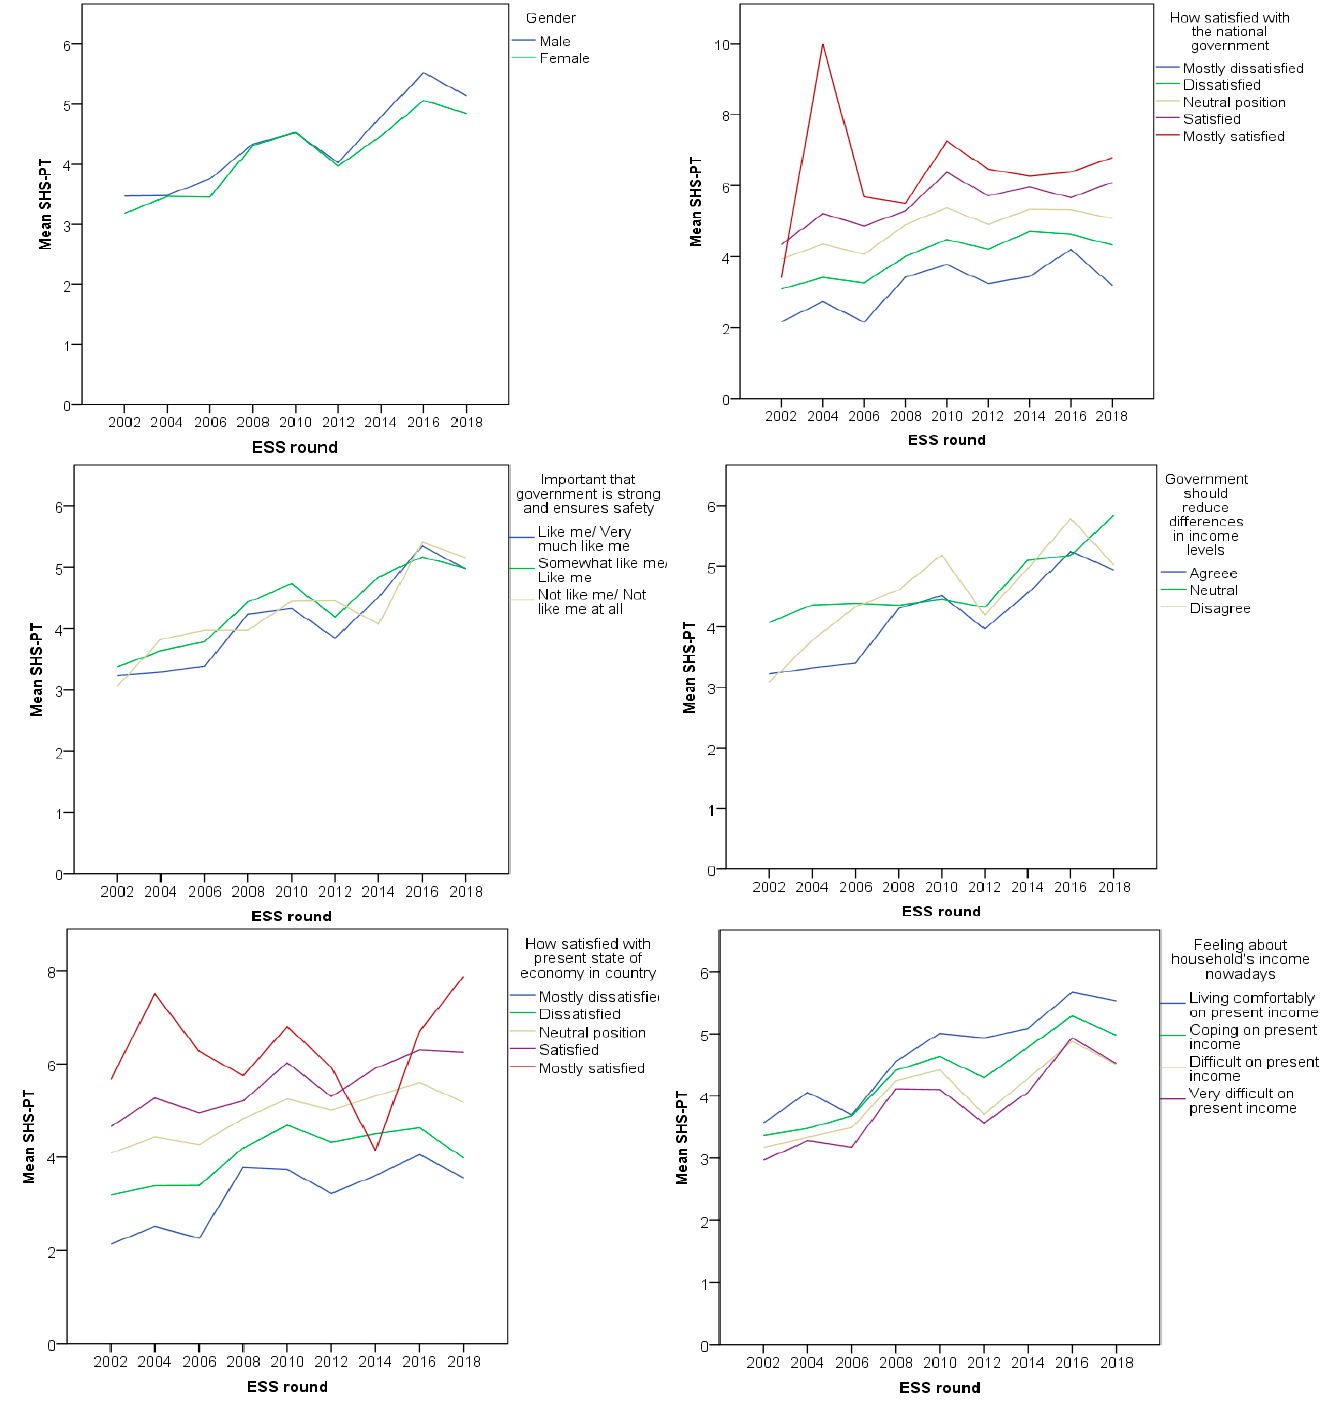
Figure 3. Relationship of ideological disposition, interest in politics, social trust, and satisfaction with the healthcare system in Portugal.